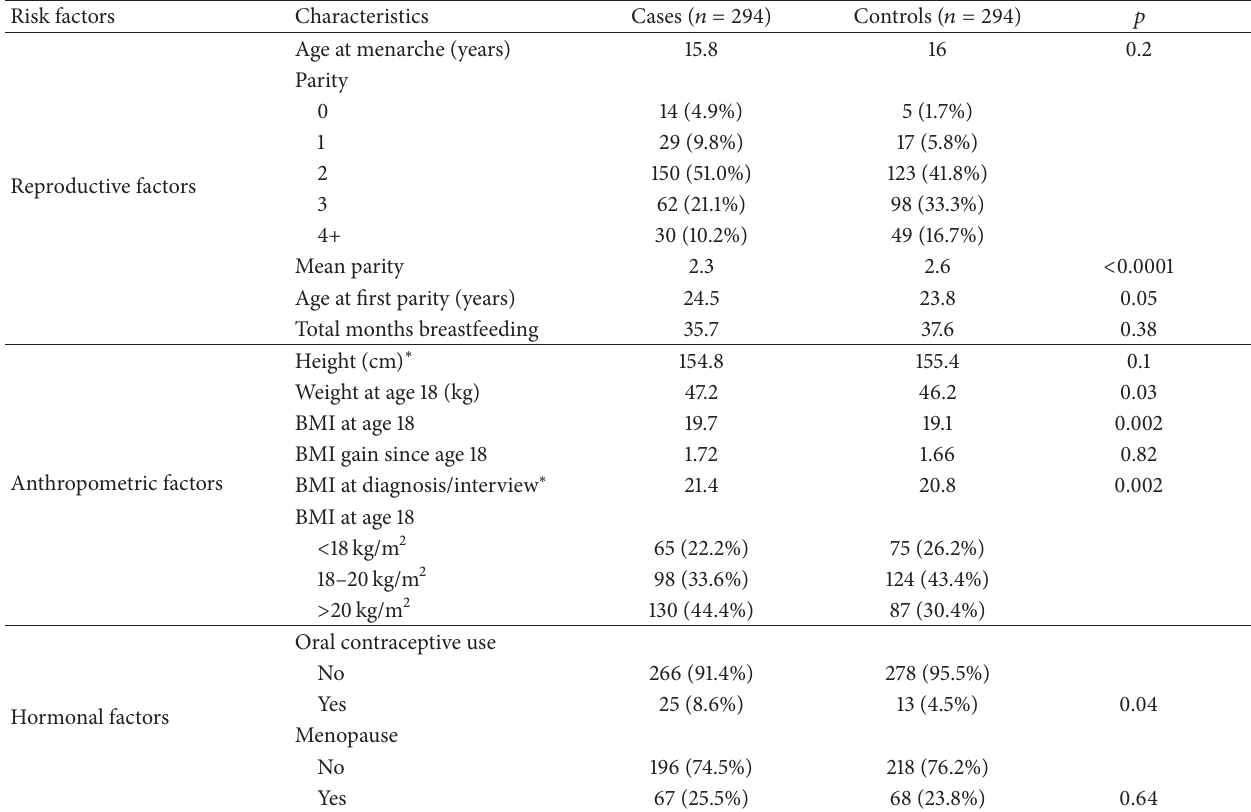
Table 2: Characteristics of breast cancer cases and matched